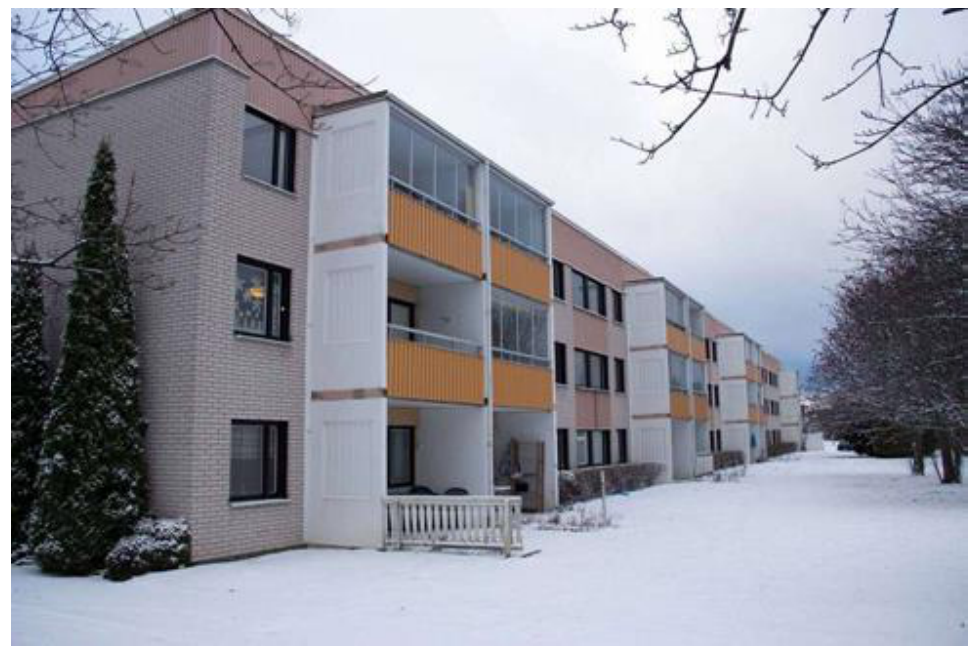
Figure 1 . Case study building. Figure 1. Case study building.